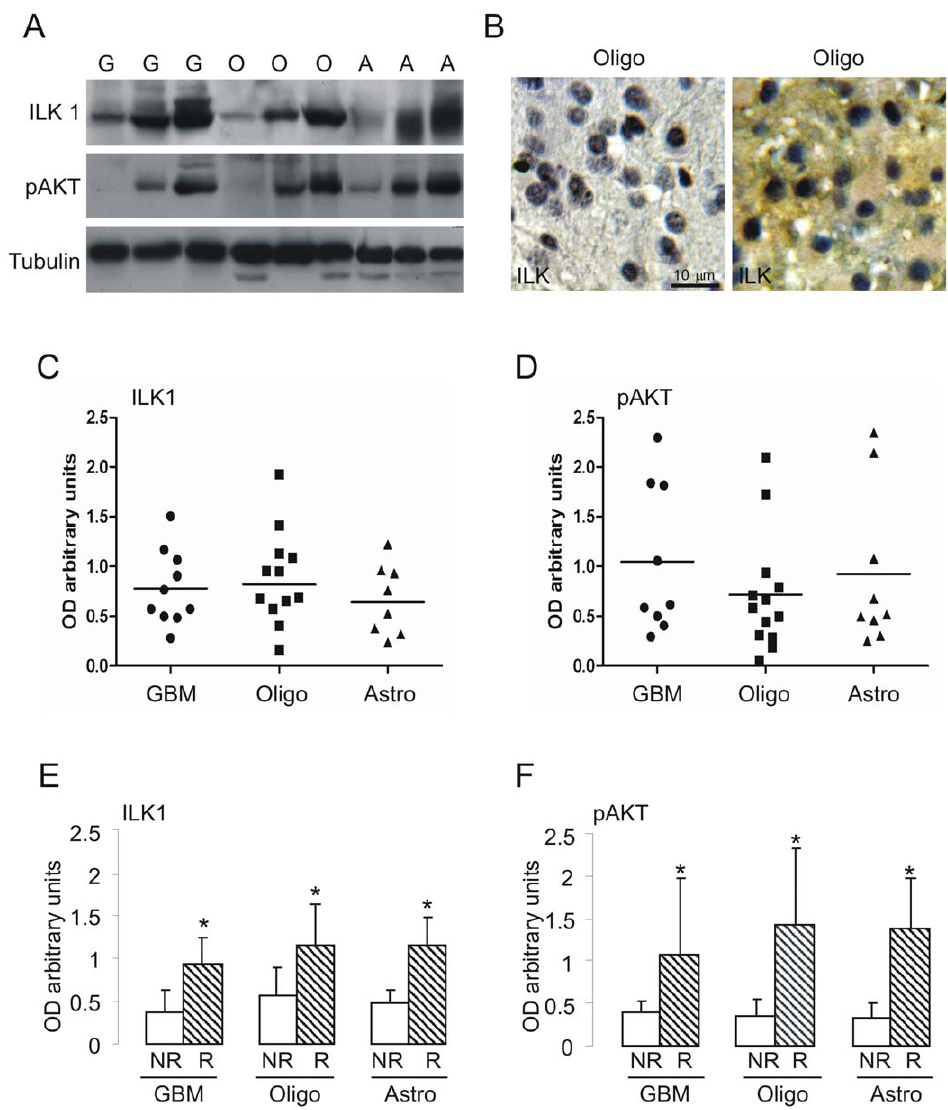
Figure 6. Immunoblotting analysis of ILK1 and pAKT levels in biopsies from patients. The expression level of ILK1 and pAKT were analyzed in biopsies from patients with glioblastomas (G), oligodendrogliomas (O) or astrocytomas (A). The tissue lysates were prepared as described in Materials and Methods, and the proteins separated in 10% gels. A) Proteins blotted onto a nitrocellulose membrane and detected using antibodies raised against the individual proteins indicated on the left side of each panel. B) Representative immunohistochemistry of ILK1 levels in different biopsies. C and D) The graphs show histological ILK1 and pAKT levels in different patients with the same type of tumor. E and F) Patients divided on the basis of the time of recurrence (NR: long-term recurrence, more than one year after treatment; R: short-term recurrence, less than four months after treatment). The histograms indicate the mean band intensity ( 6 SEM) for each protein. *p , 0.05, t test. The expression of ILK1 and pAKT was significantly upregulated in the subset of patients with a poor prognosis, regardless of the type of glioma.